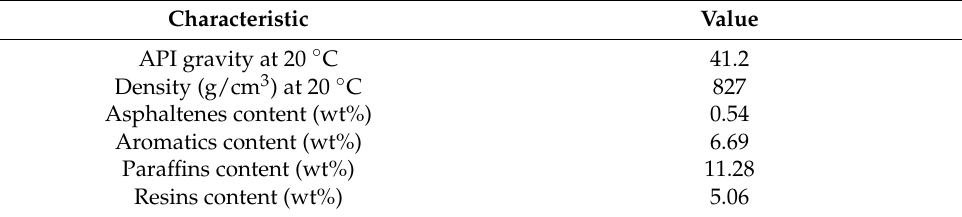
Table 1. Crude oil